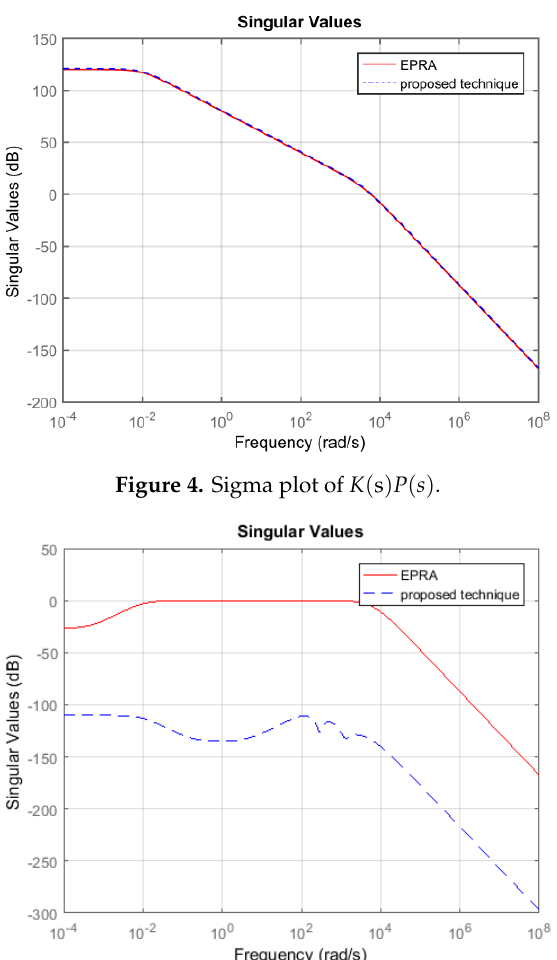
Figure 5. Sigma plot of the weighted error W ̅̅̅ 𝑜 (𝑠)[𝐾(𝑠) − 𝐾 𝑟 (𝑠)].